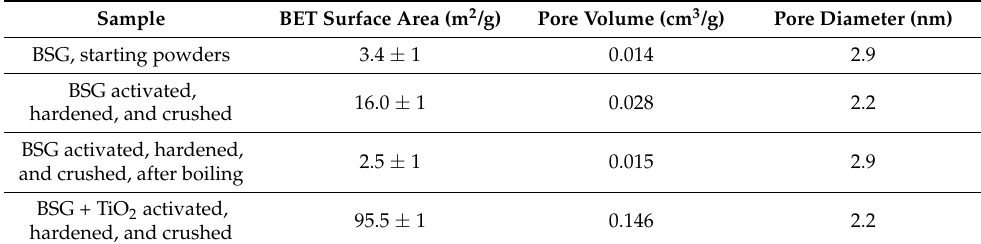
Table 2. Results of BET characterization of BSG